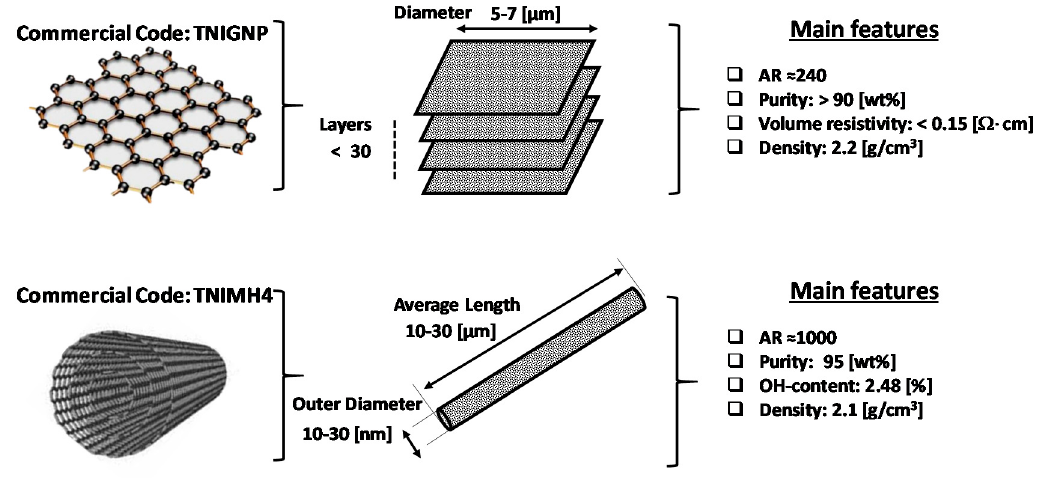
Figure 1. Main features of the adopted graphene nanoplates and multiwall carbon nanotubes.